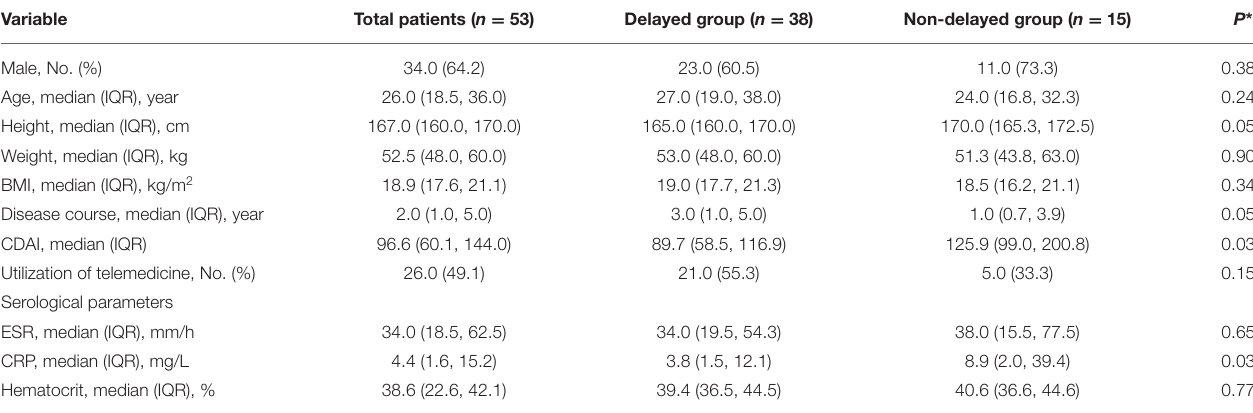
TABLE 1 | Baseline characteristic of the enrolled patients.